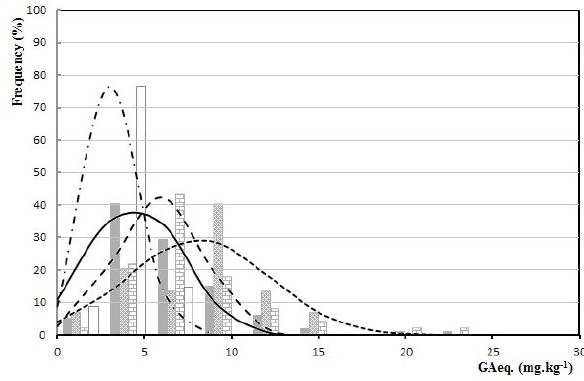
Figure 4: Distribution of total polyphenols expressed as galic acid equivalent in oats (solid column and line – complete set, r 2 = 0.923, bracket column and dash line – minor, red subset, r 2 = 0,764, dots column and dash-and-dot line – major, green subset, r 2 = 0.967, empty column and dots line – major, blue subset, r 2 = 0.999, the mentioned colors correspond to the colors in Fig. 2 and Fig. 3).